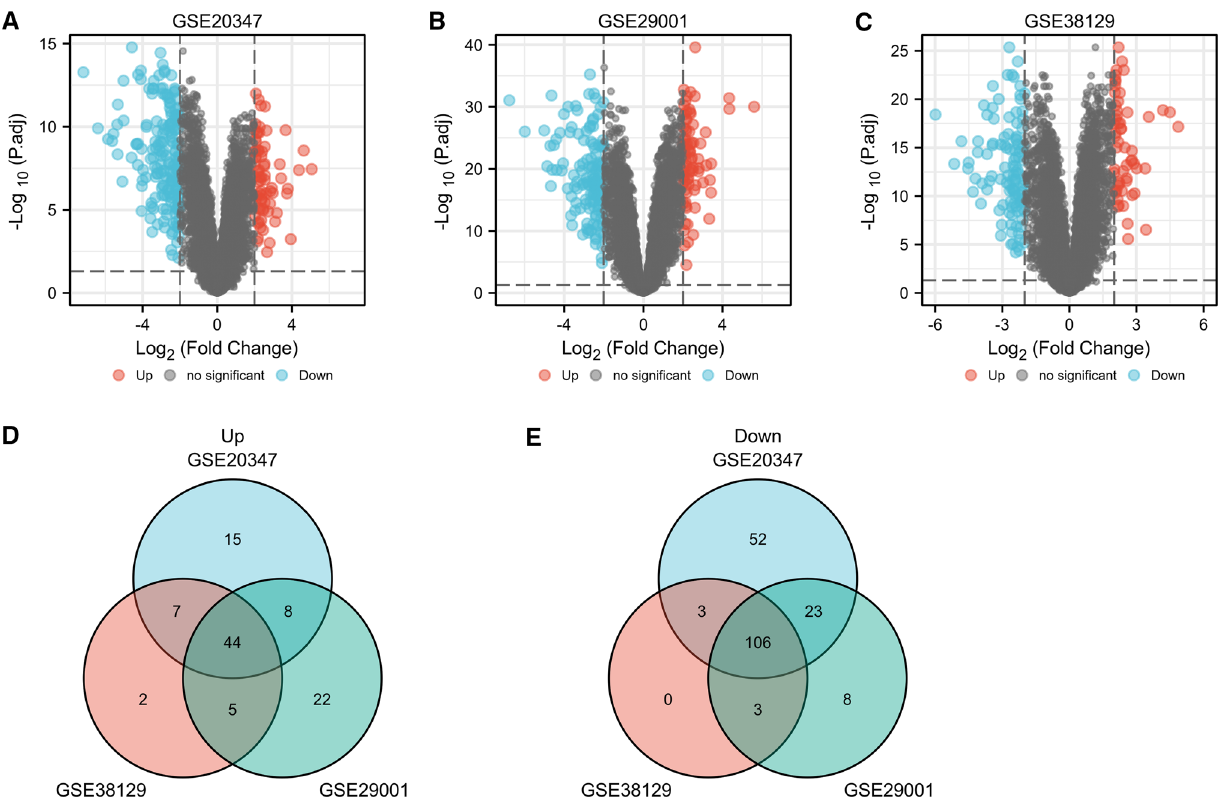
Fig. 1 Identification of DEGs. A – C Volcano plots of DEGs in GSE20347, GSE29001 and GSE38129 datasets. D , E Venn plots of overlapping DEGs among GSE20347, GSE29001 and GSE38129 datasets. DEGs, differentially expressed